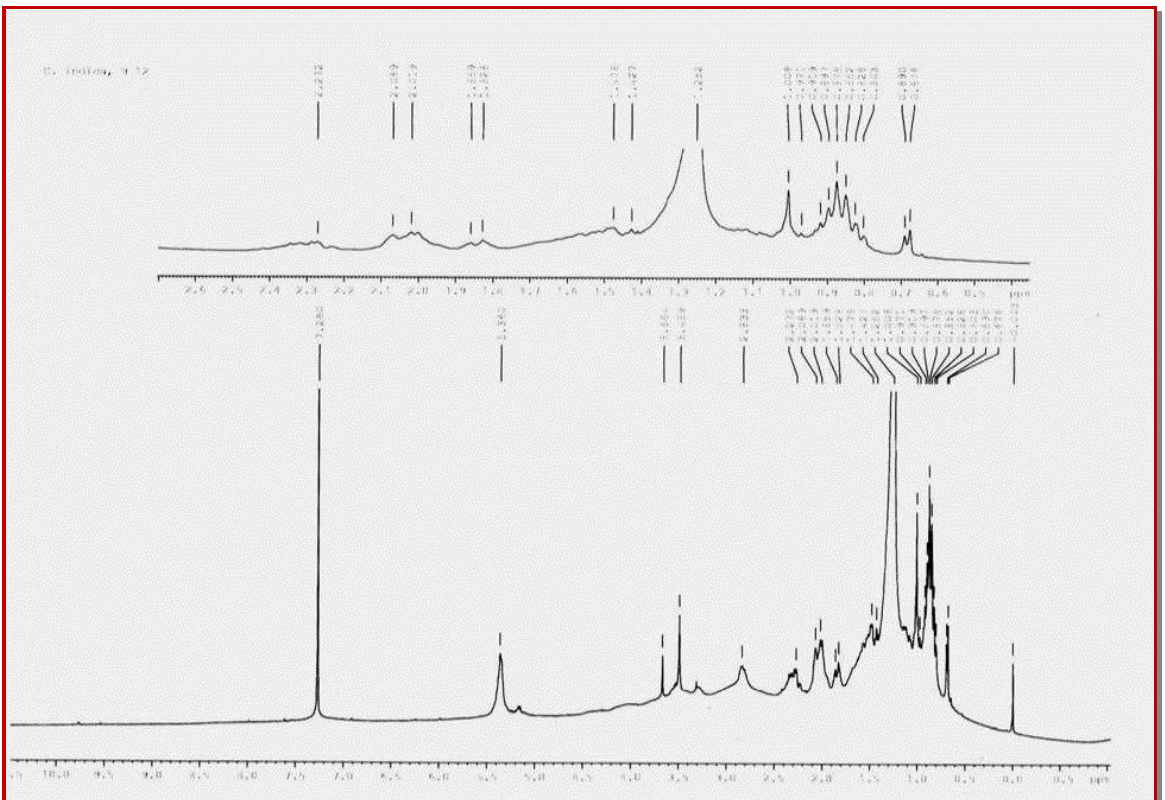
Figure 2: The 1H NMR spectrum of peptides in M.